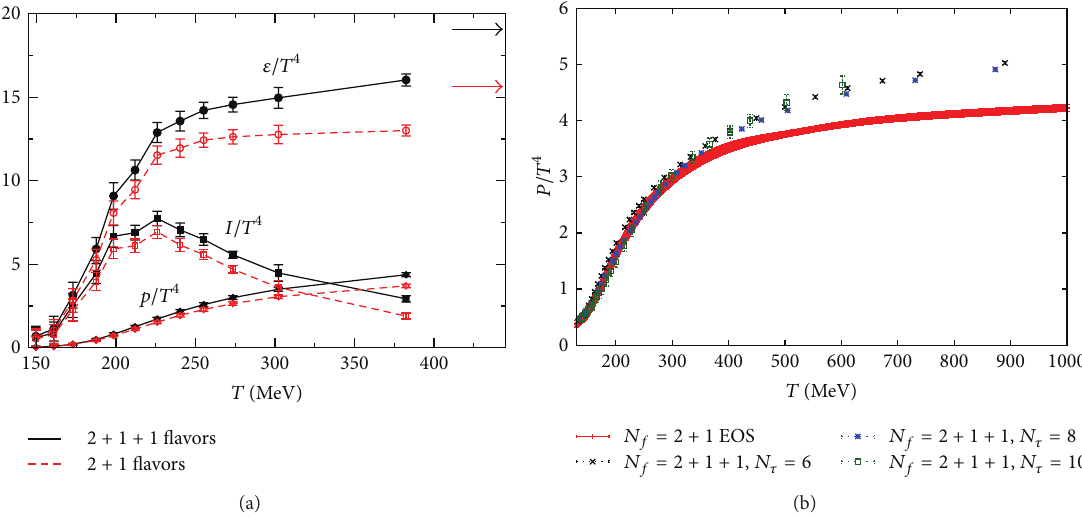
Figure 9: In (a), the effects of quenched charm quark to the pressure, energy density, and trace anomaly are shown as a function of temperature, from [66]. The lattice size is 24 3 × 6 . In (b); the effects of dynamical charm quarks to the pressure are shown as a function of temperature, from